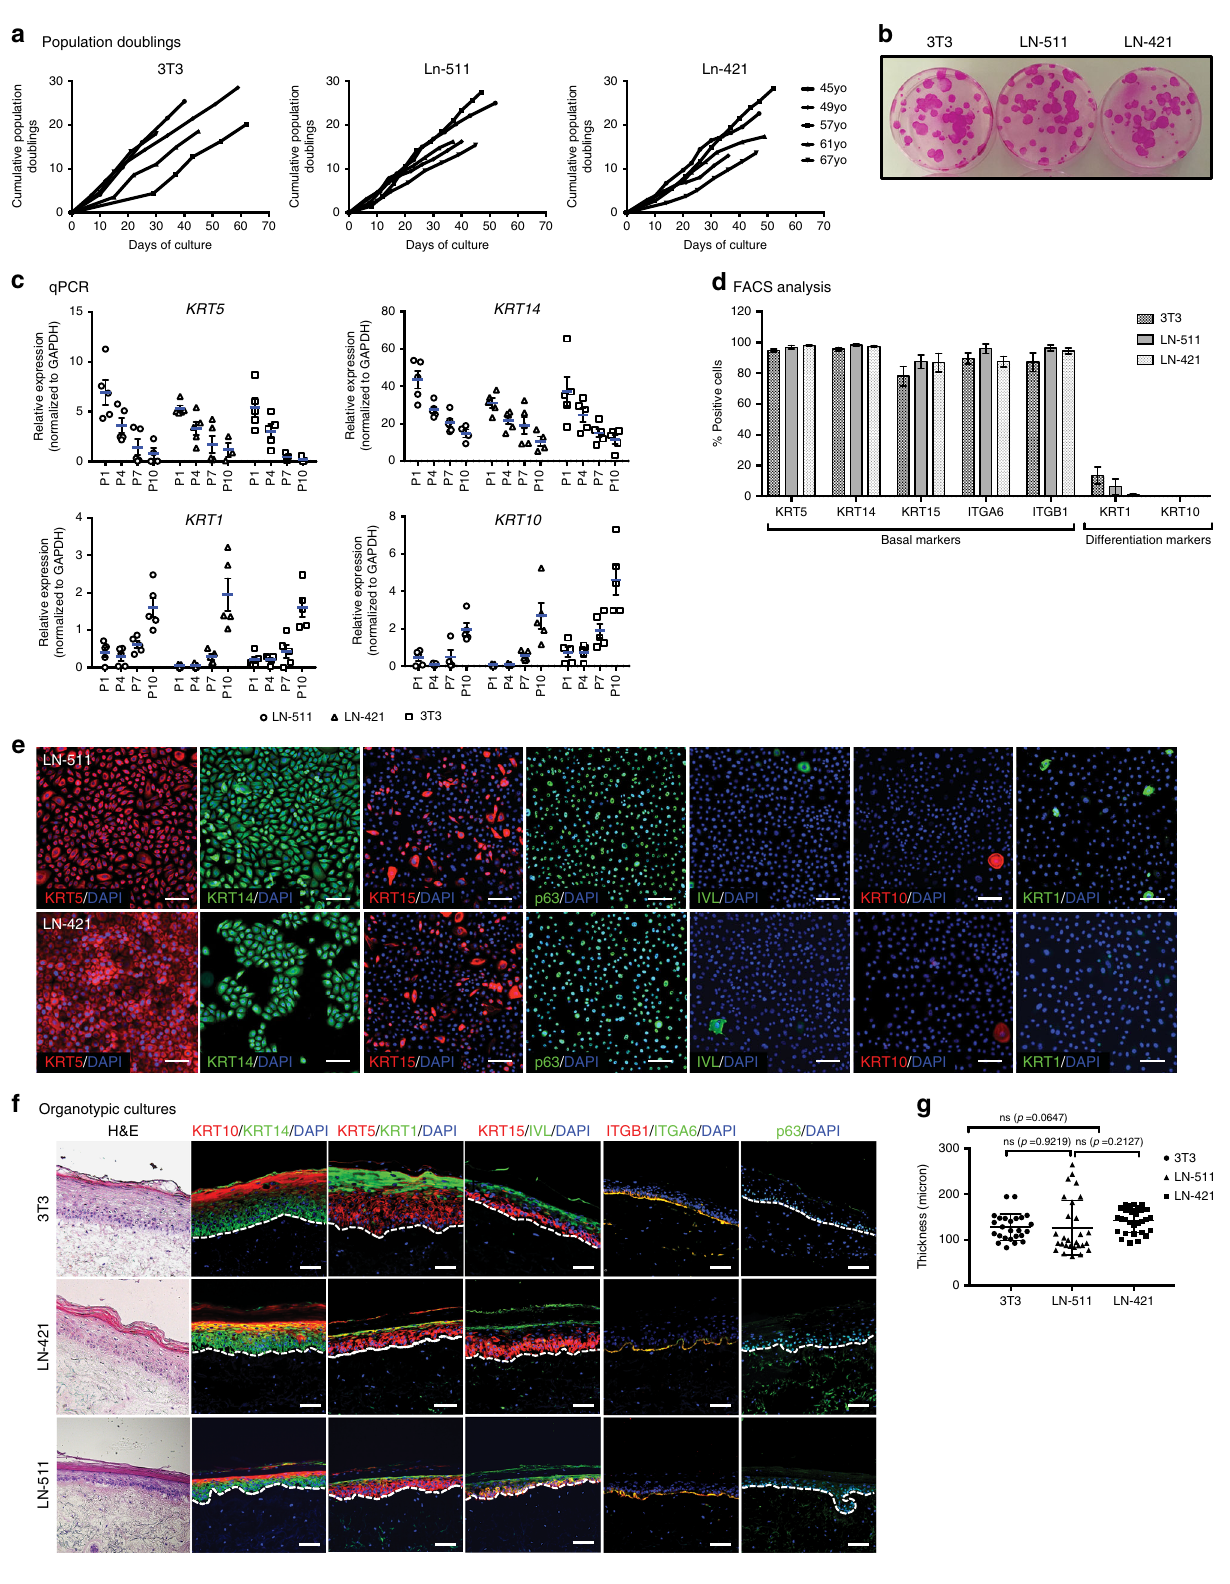
Transcriptomic pro fi le of HEKs cultured on LN system . We levels in the different three culture systems, con fi rming that the further pro fi led and compared the transcriptome of HEKs grown cells grown on the tested platforms were all progenitors (Fig. 3a). on LN-421, LN-511, and using 3T3 co-culture system by RNA- Overall, keratinocytes grown on LN-421 and LN-511 showed seq. Basal and differentiation markers showed similar expression similar transcriptomic pro fi les: Spearman ’ s ranked correlation of NATURE COMMUNICATIONS| (2018) 9:4432 |DOI: